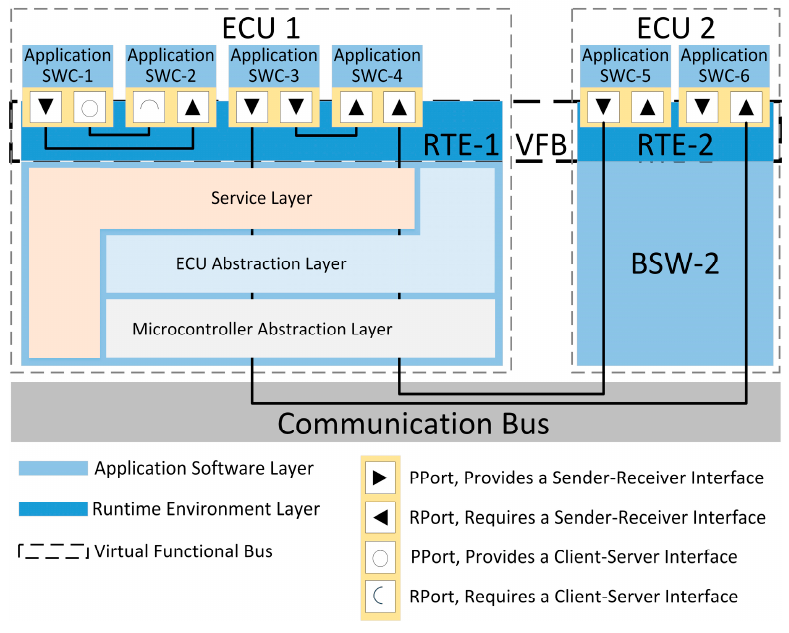
Figure 1. Simplified AUTOSAR software architecture.